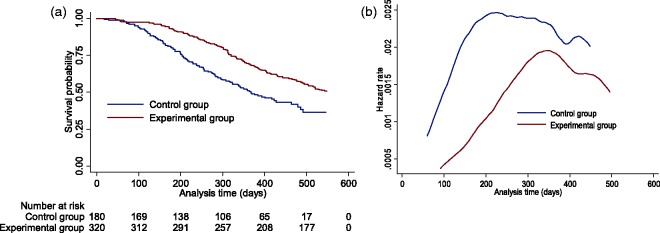
One simulated dataset from Scenario 13 with no switching: (a) Overall survival Kaplan–Meier; (b) smoothed hazard rate.